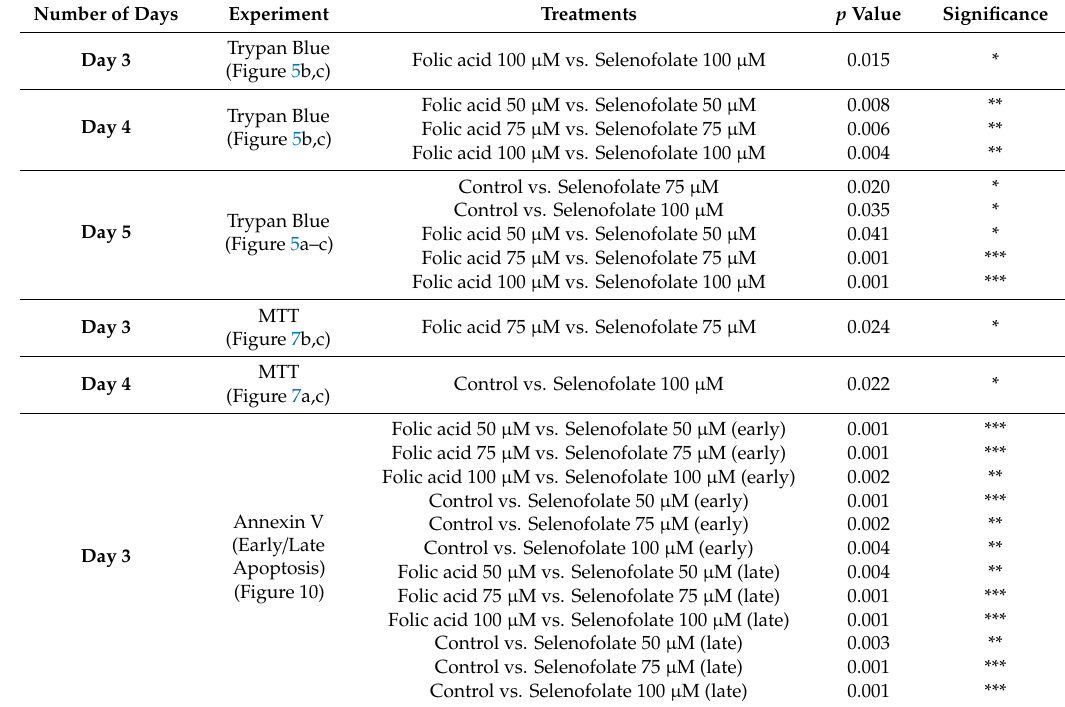
p ≤ 0.05 (*), p ≤ 0.01 (**), and p ≤ 0.001 (***), 50 µ M = 2 µ g Se, 75 µ M = 6 µ g Se, 100 µ M = 8 µ g